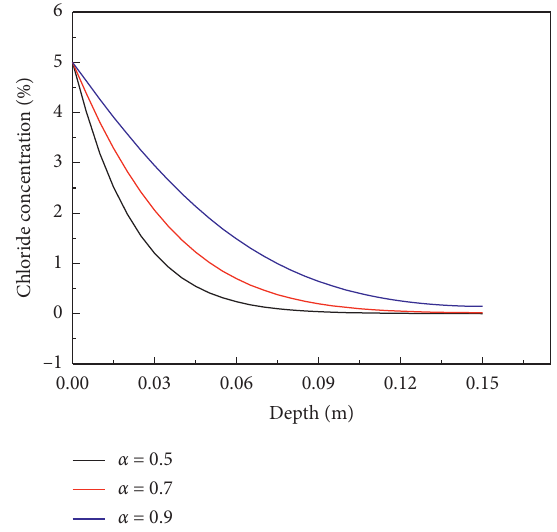
Figure 2: Chloride concentration-depth with different α in TFC ( t � 50 years).